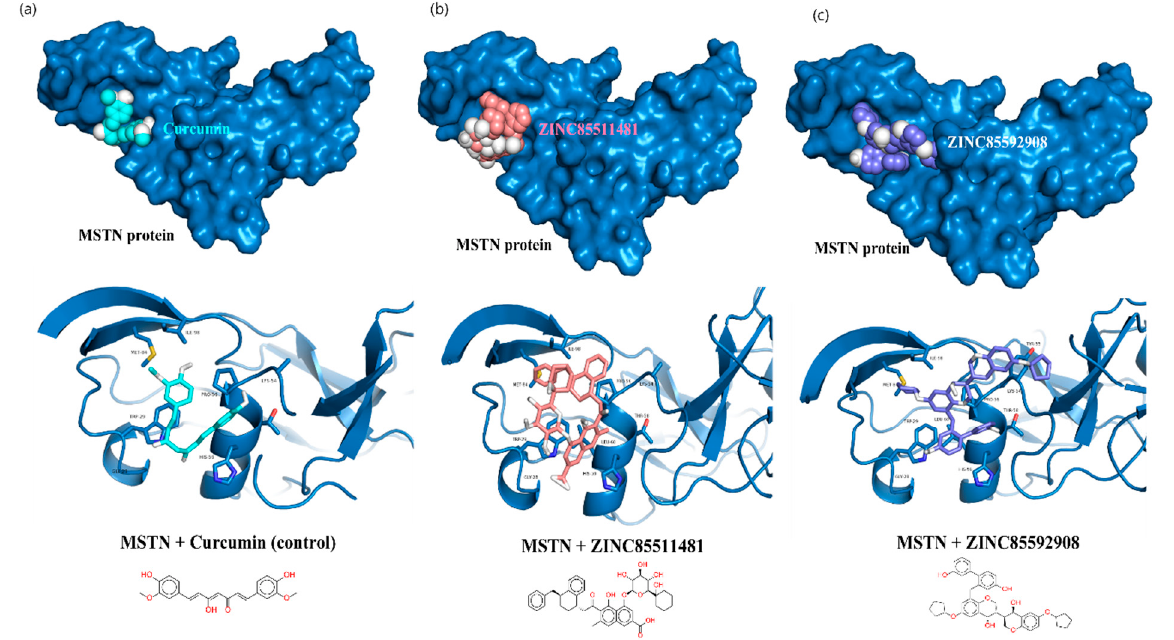
Figure 2. Interaction analysis of potential leads in their active pocket site, ( a ) MSTN-Curcumin, ( b ) MSTN-ZINC85511481 and ( c ) MSTN-ZINC85592908. ( b ) MSTN-ZINC85511481 and ( c )